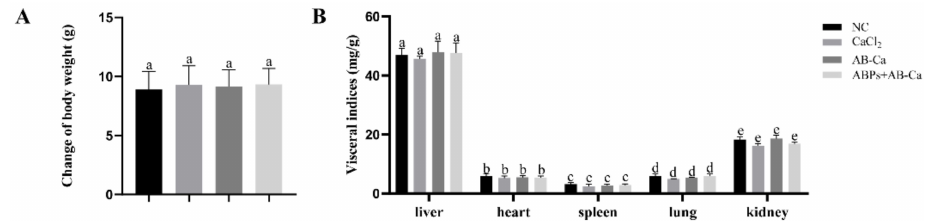
Figure 5. Change in body weight ( A ) and visceral index of different viscus ( B ) in different groups. Data are expressed as the mean ± SD (n = 8). Columns labeled with different letters (a, b, c, d and e ) are significantly different ( p < 0.05), while with the same letters are not ( p >